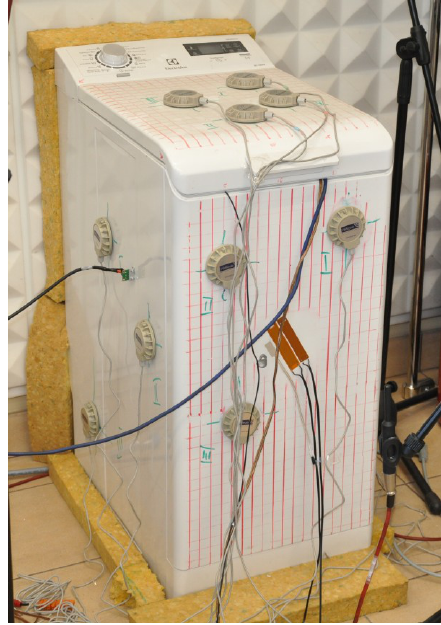
Figure 2. The washing machine used for experimental